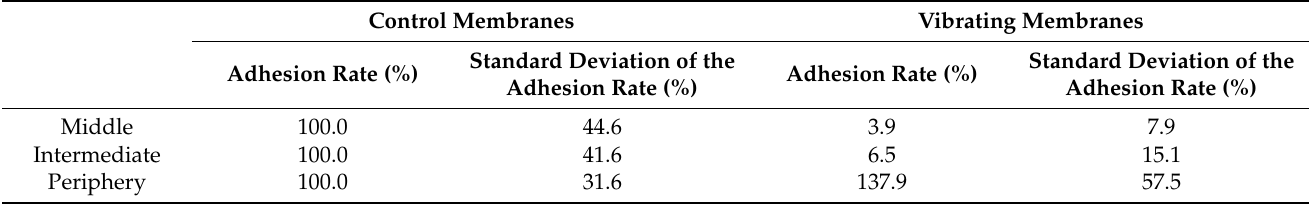
Figure 9. Adhesion rate (%) of TC8 bacteria for vibrating and control membranes. Table 2. Adhesion rate of TC8 for vibrating and control